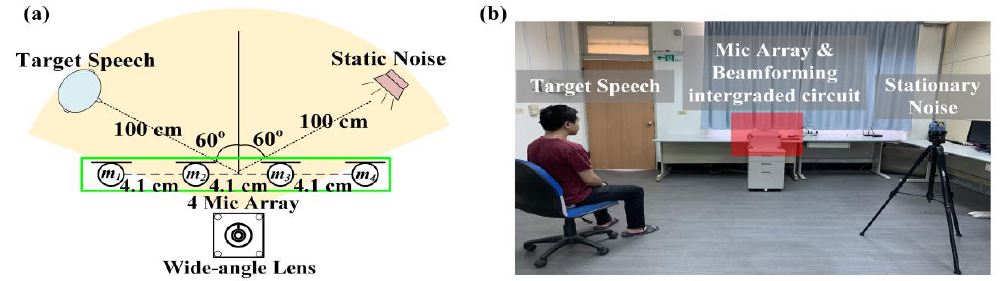
Figure 7. ( a ) Simulation experiment environment schematics; ( b ) Stationary noise and target sound source configuration scenario.